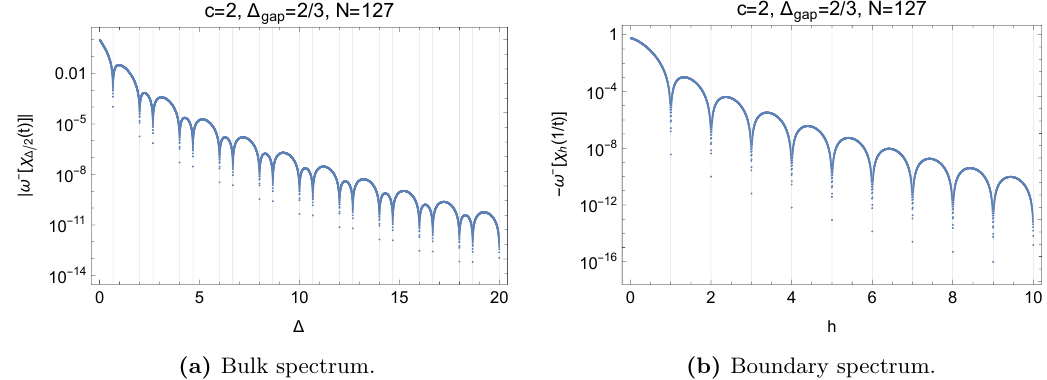
Figure 6. Action of the functional ω − that computes the lower bounds on g for the SU(3) 1 WZW model on the bulk and boundary characters. We plot the absolute value of the functional acting on bulk characters because when we feed in the information of the low-lying scalars into the numerics, the resulting functional has single rather than double zeros at these